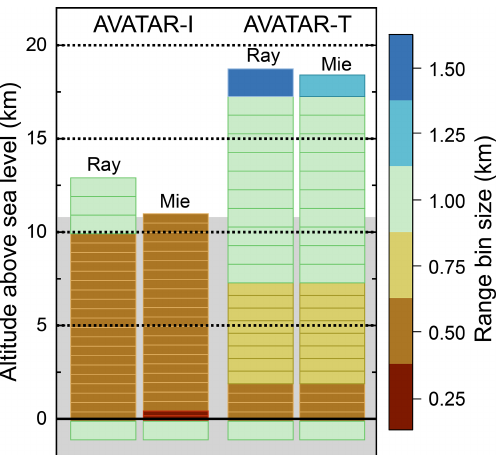
Figure 2. Aeolus range bin settings (RBSs) for the Rayleigh and Mie channel applied during the AVATAR-I and AVATAR-T cam- paigns. The actual range bin size is color coded, and the gray area indicates the altitudes that are usually sampled by the airborne lidars on board the Falcon